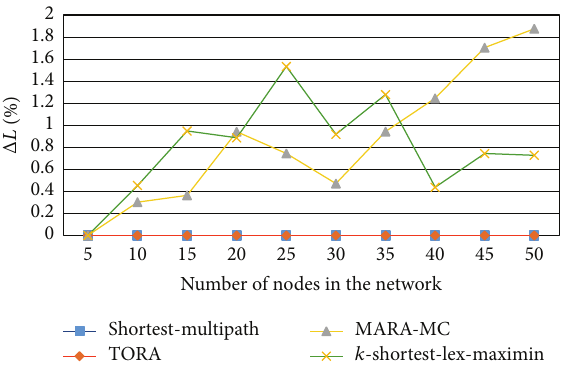
Figure 5: Average DODAG-to-network shortest path length gap in function of the size of the